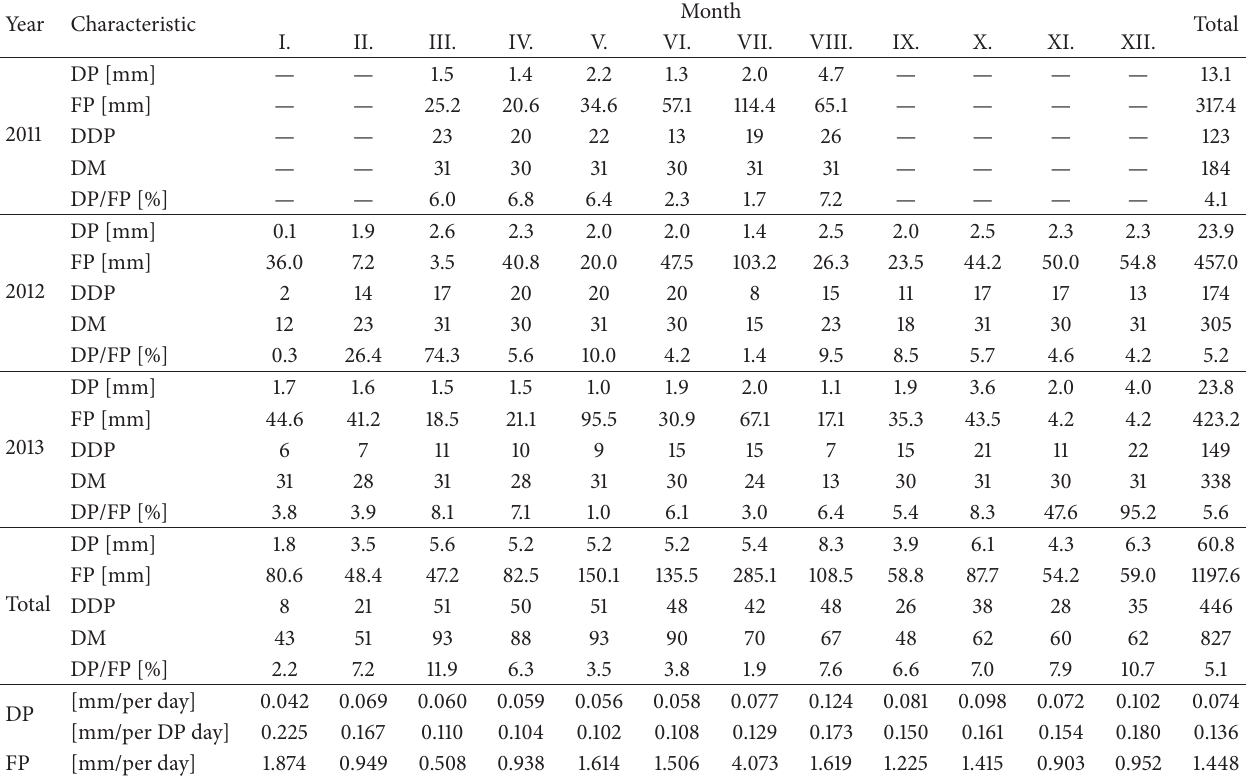
Table 1: Evaluation of precipitation amount in Suchdol, Prague locality.